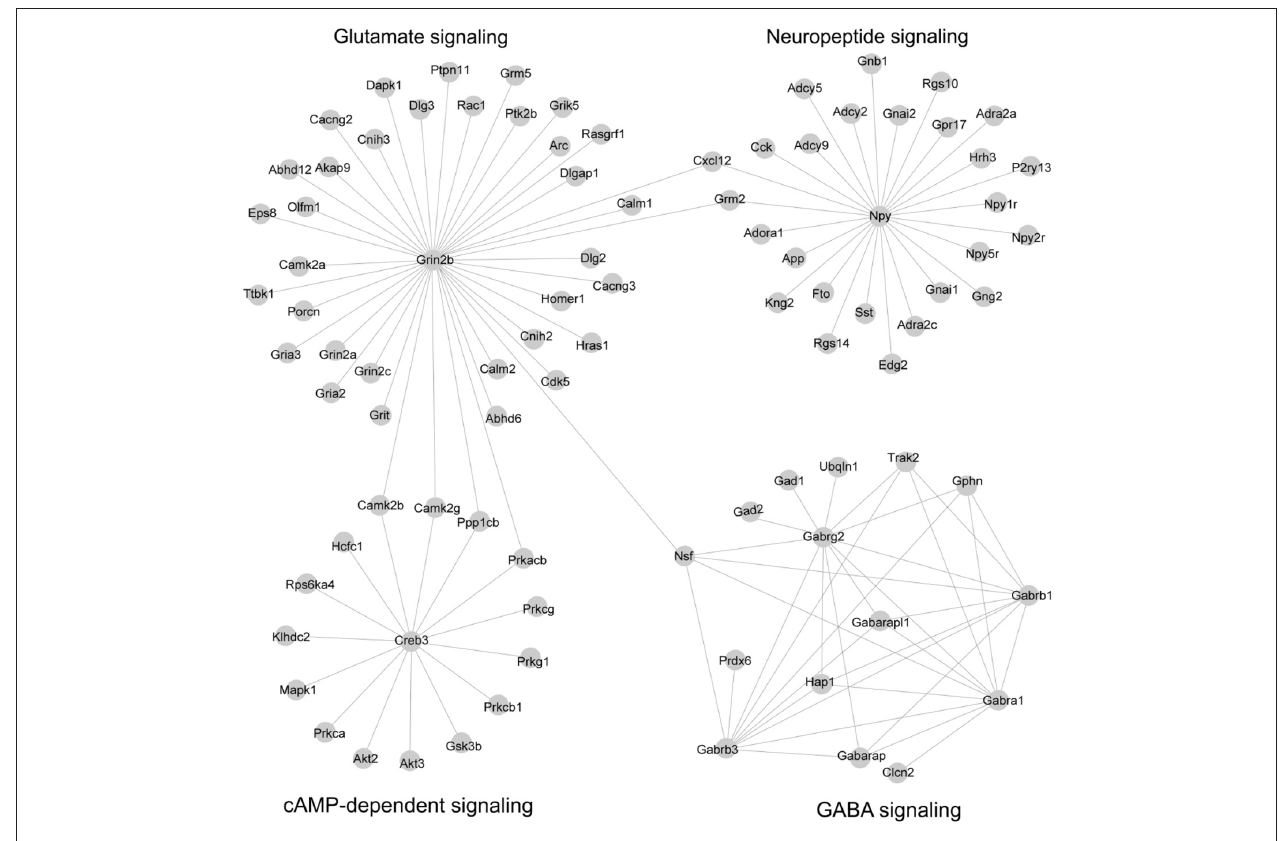
FIGURE 3 | Subnetworks were constructed by combining co-expression network and protein-protein interaction (PPI) network. A total of 14 co-expression modules identified by co-expression analysis were superposed with PPI networks from the STRING database, leading to four subnetworks. The network was visualized by Cytoscape